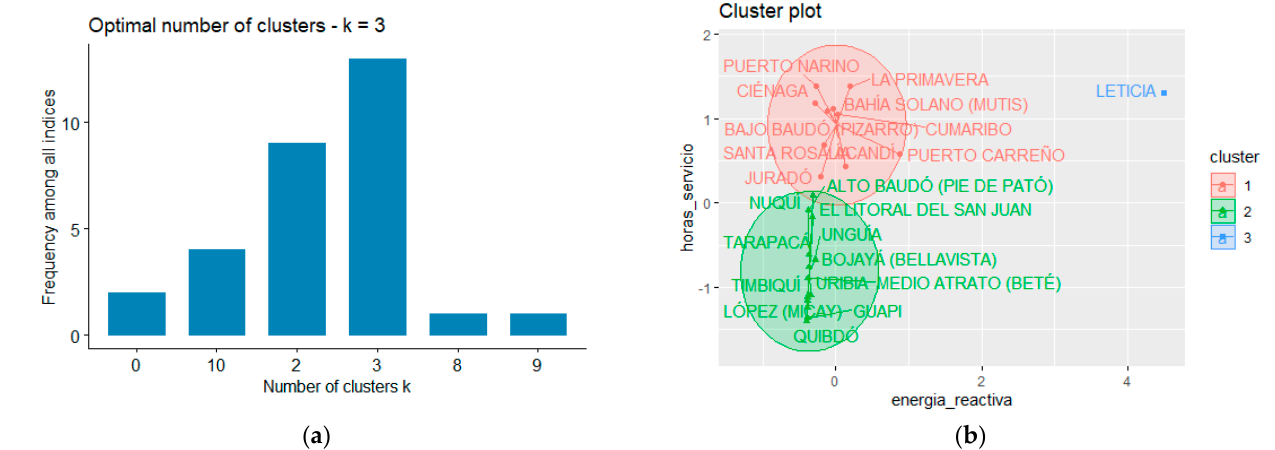
Figure 8. ( a ) Optimal number of clusters; ( b ) clusters by K-medoids algorithm (municipalities,